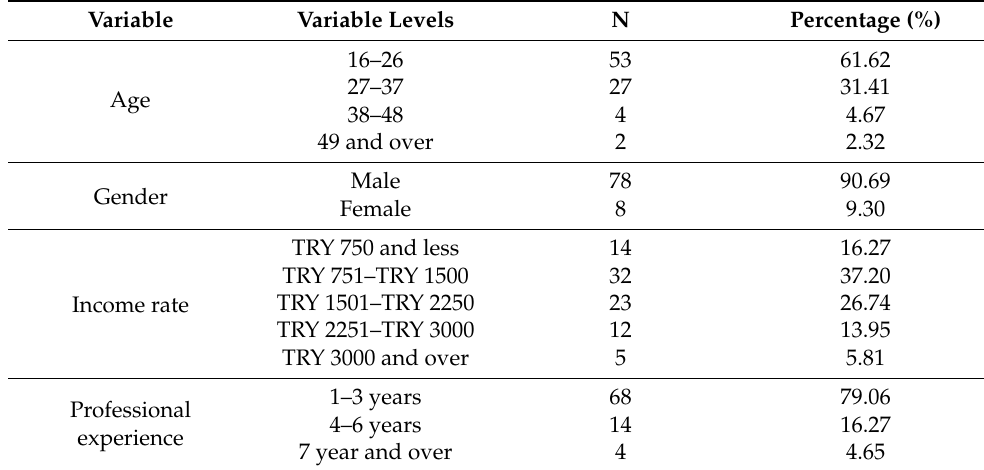
Table 2. Demographic information of the attendances.